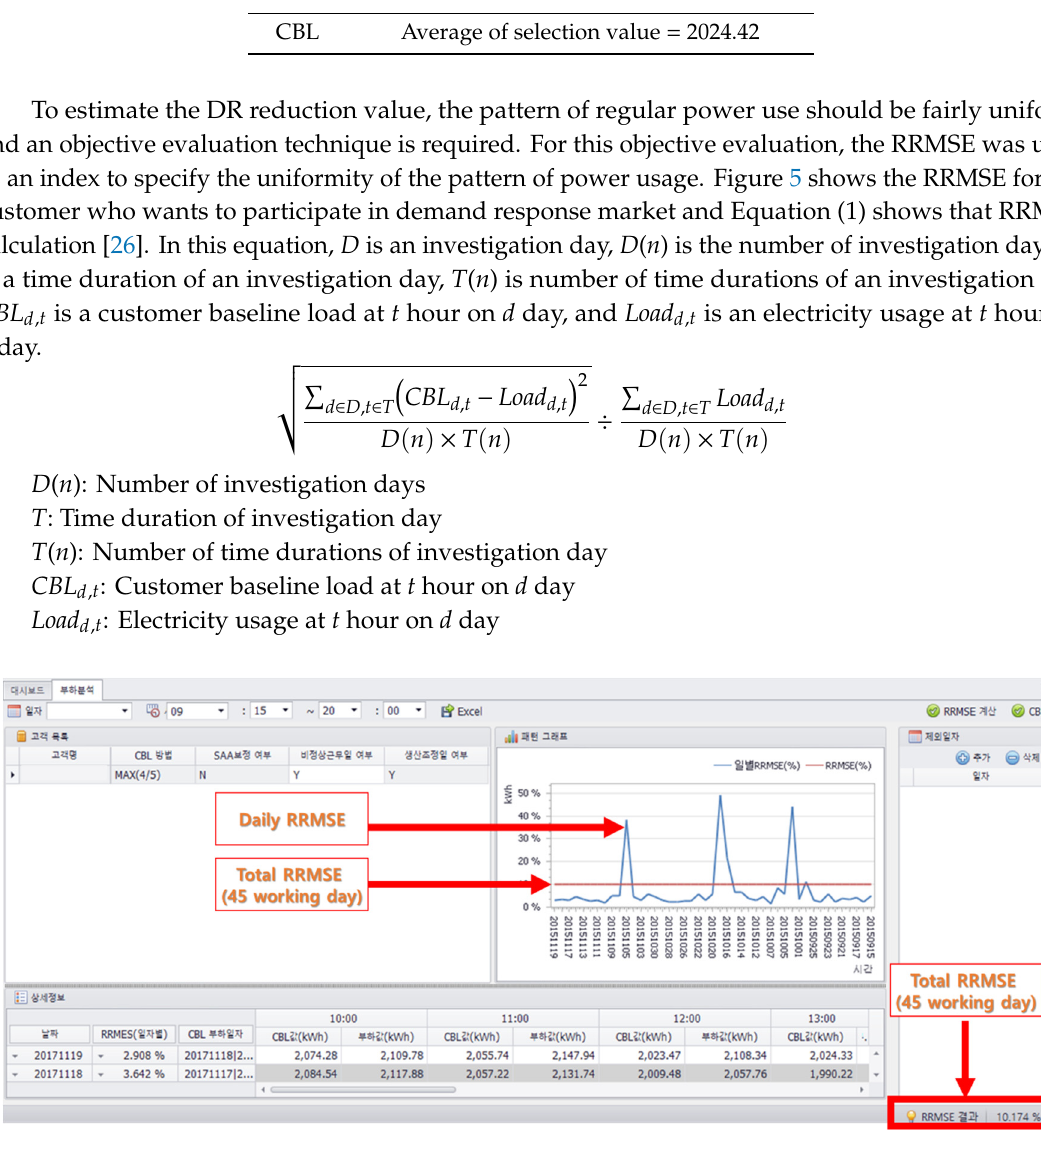
Figure 5. Relative root mean squared error (RRMSE) for a customer.